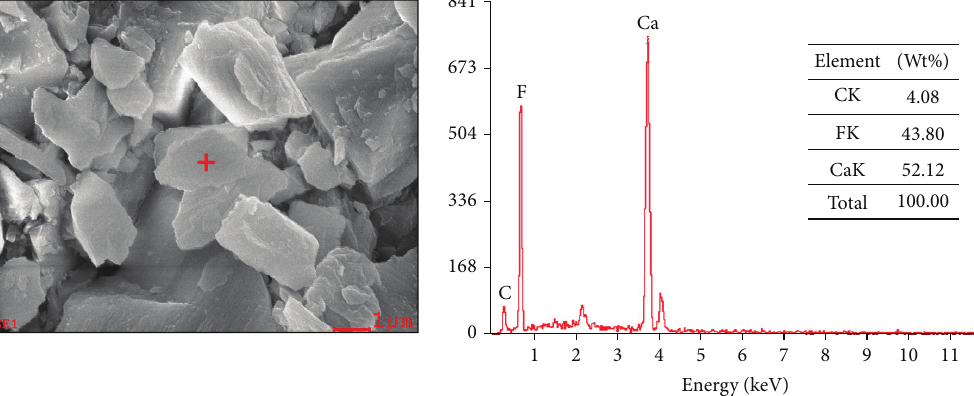
Figure 4: FESEM-EDX analysis of